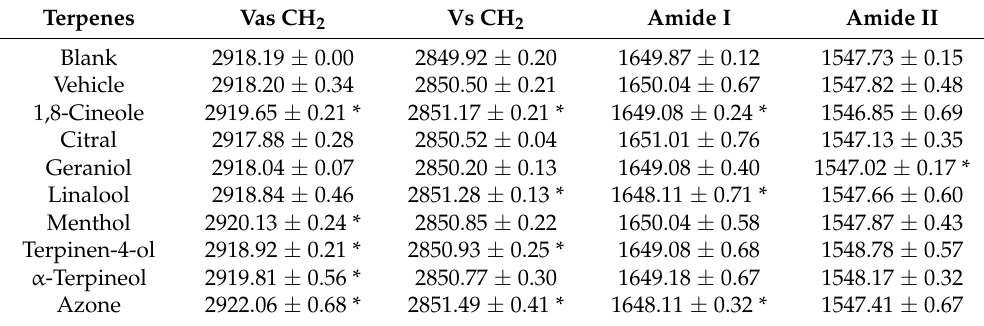
Table 5. Peak positions in Attenuated Total Reflection-Fourier Transform Infrared Spectroscopy (ATR-FTIR) spectra of skin samples for the treatment of different oxygen-containing terpenes (n = 4).